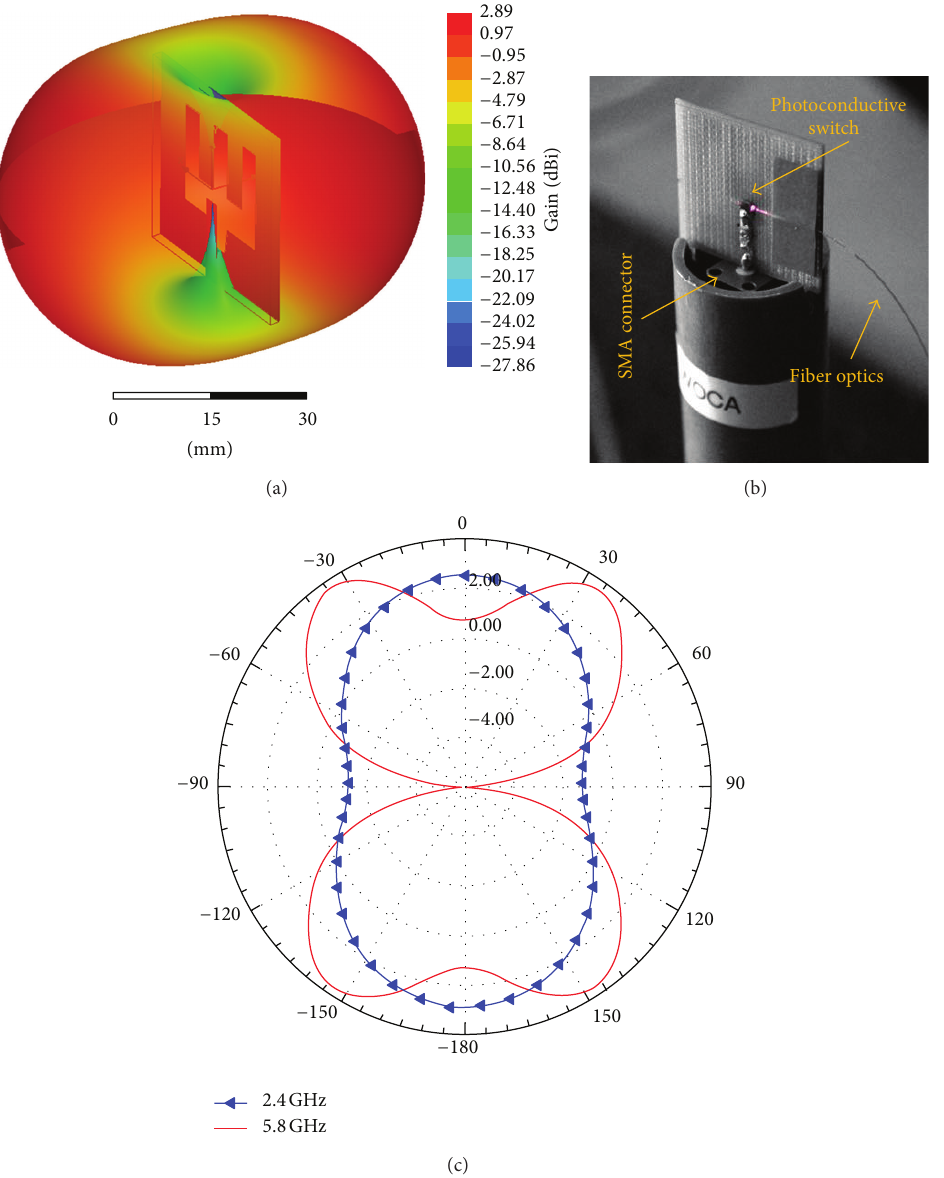
Figure 7: “E”-shaped optically controlled reconfigurable